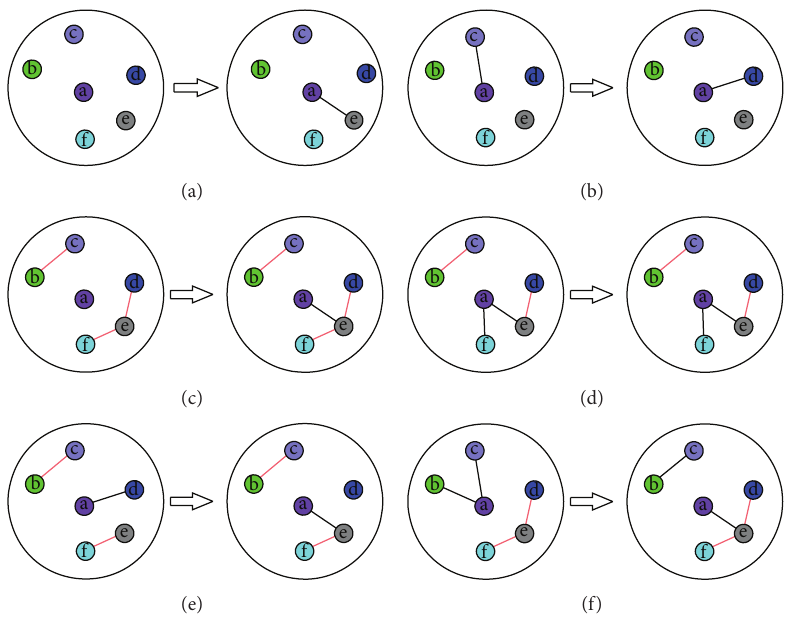
Figure 2: An illustration of network construction rules.